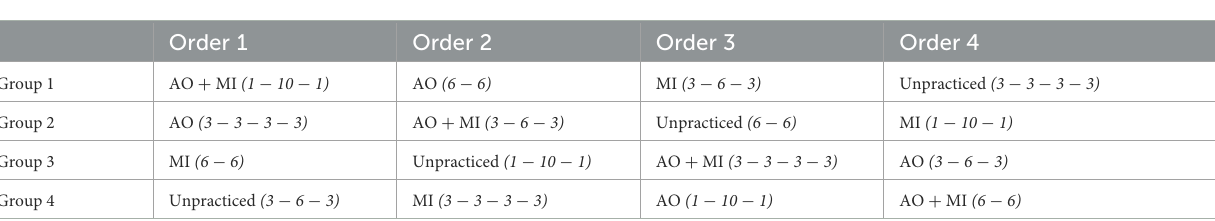
TABLE 2 Graeco-Latin square